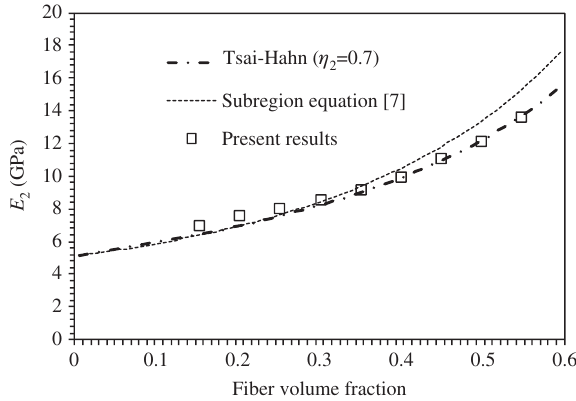
fiber volume fraction values are also depicted in Figure 3